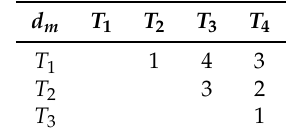
Table 2. The mixture distances d m among T 1 , T 2 , T 3 and T 4 .